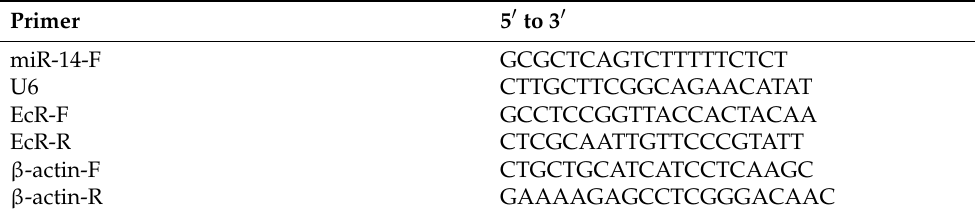
Table 1. Primer sequences used for qRT-PCR validation of miR-14 and